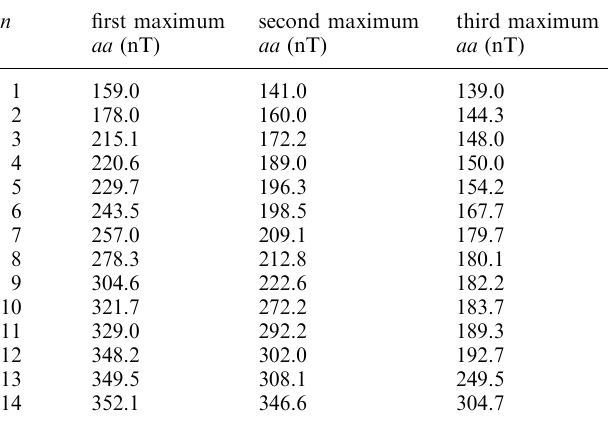
Table 2. Extreme daily aa indices from Table 1 arranged in order of increasing magnitude